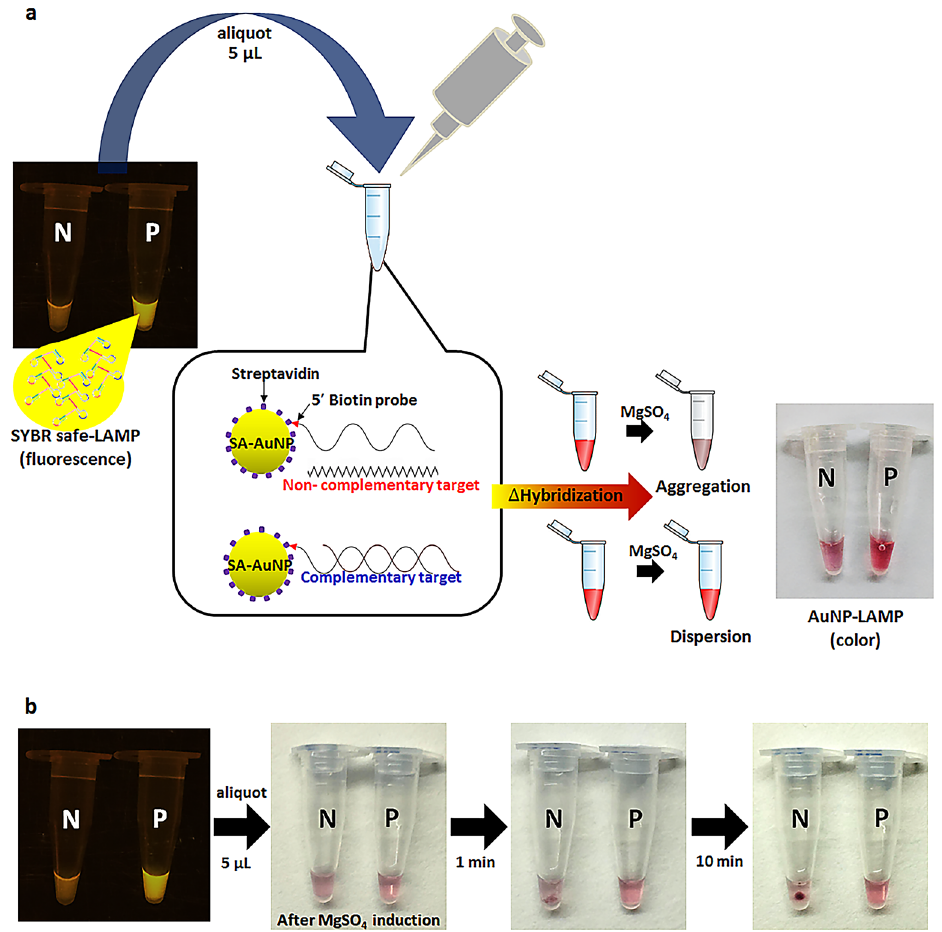
Figure 1. Procedure of LAMP detection using gold nanoparticles (AuNPs) probe in one-step SYBR safe and AuNP-LAMP assay, ( a ) schematic representation of experimental principle and signal detection to visualize LAMP products by post hybridization of probe-streptavidin conjugated AuNPs (probe-SA-AuNPs), ( b ) colorimetric and precipitate interpretation of probe-SA-AuNPs in postamplification LAMP mixture after MgSO 4